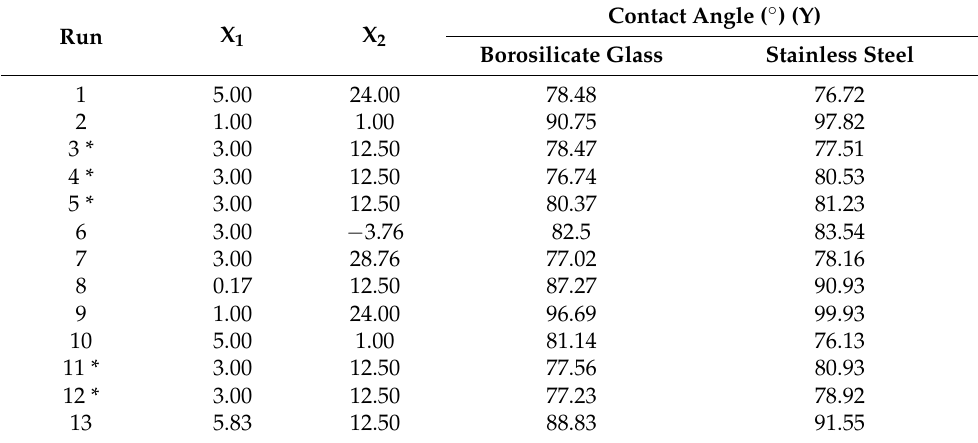
Table 3. Actual levels of the independent variables along with the observed values for the response variables, the contact angle of the borosilicate glass and stainless steel treated with